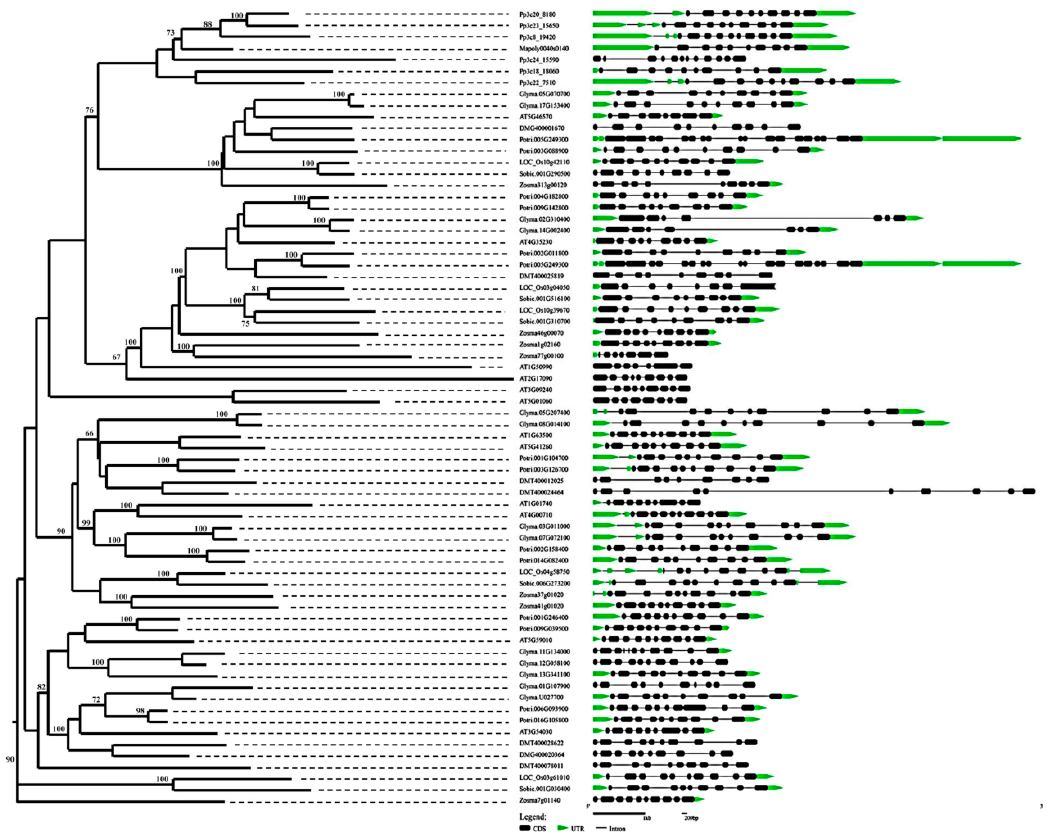
Figure 3. Phylogenetic relationship and exon-intron structure of BSK genes in representative plants. The BSKs were divided into five subgroups, which are indicated by different colors. The black boxes represent exons, solid lines represent introns, and green boxes represent untranslated regions (UTRs). The lengths of the BSK genes are indicated by horizontal lines (kb).